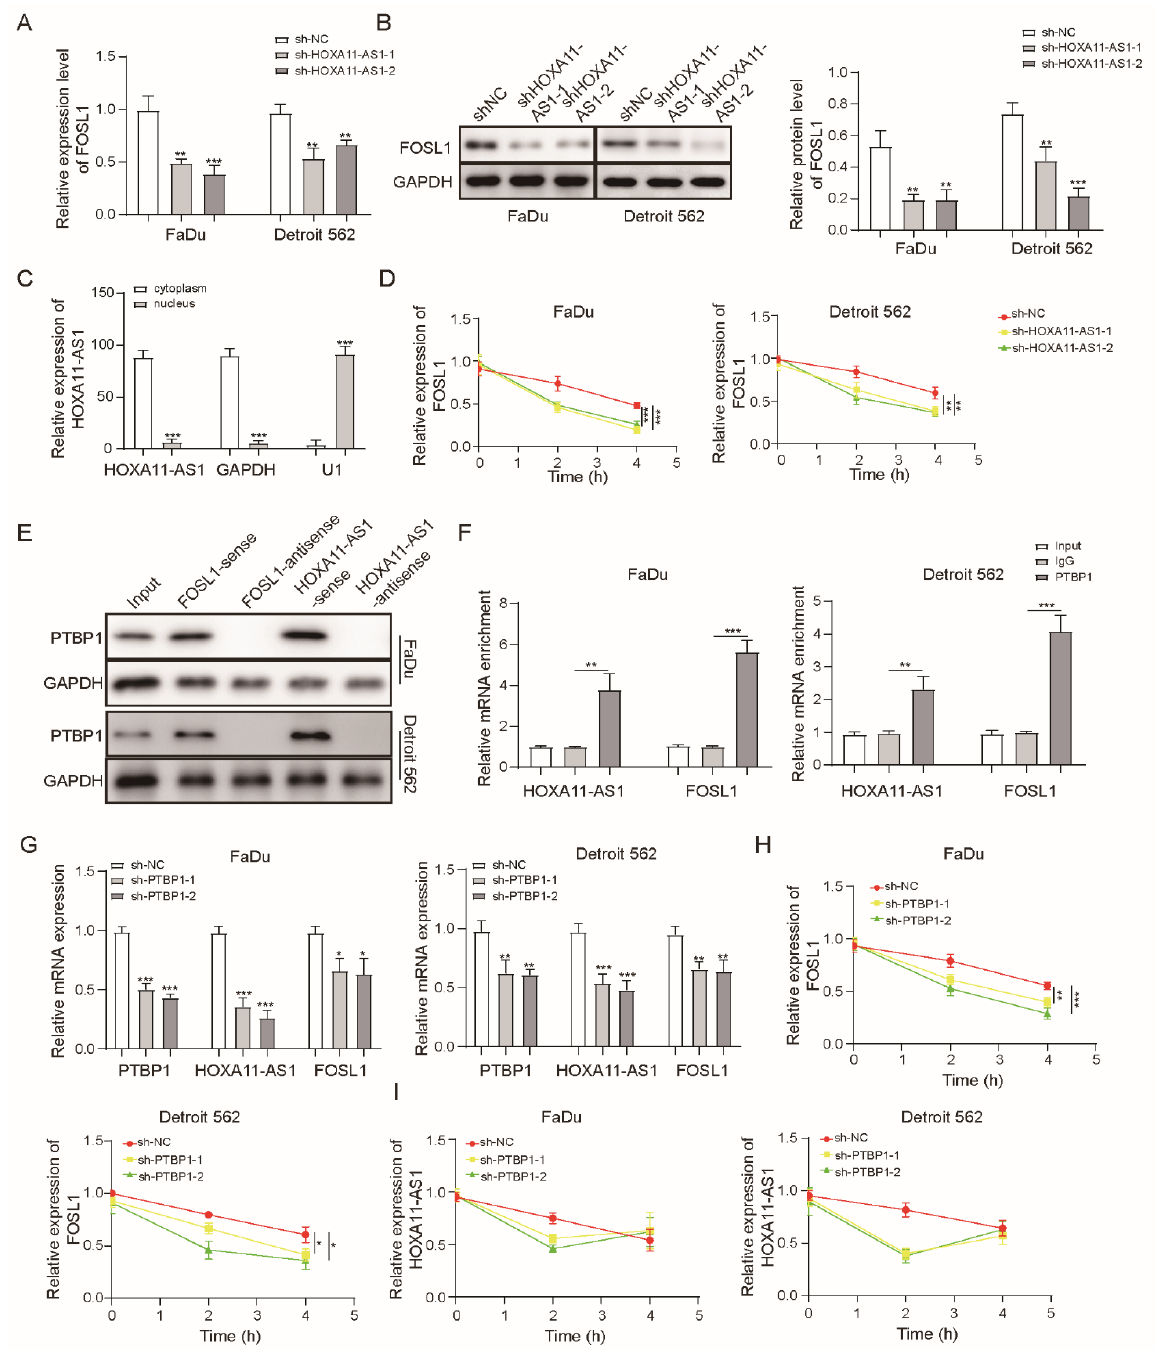
Figure 4. HOXA11-AS1 enhanced FOSL1 mRNA stability by binding PTBP1. ( A , B ) FOSL1